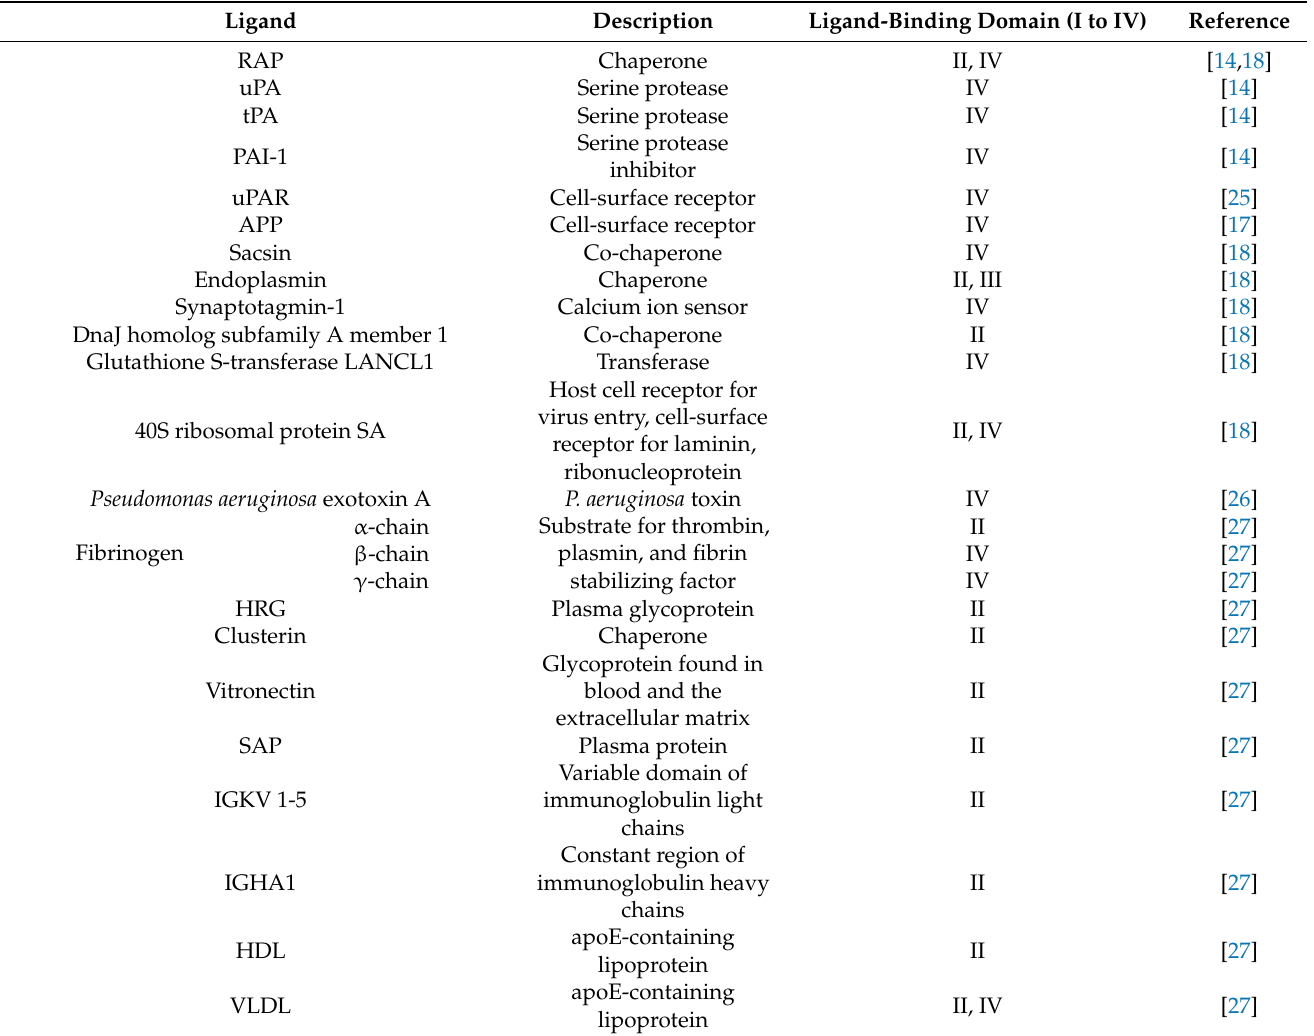
Table 1. Extracellular ligands and membrane-associated receptors of